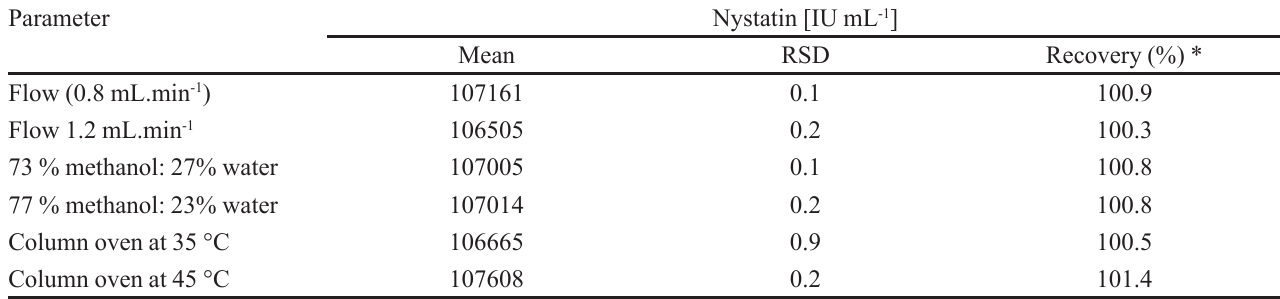
TABLE V - Robustness